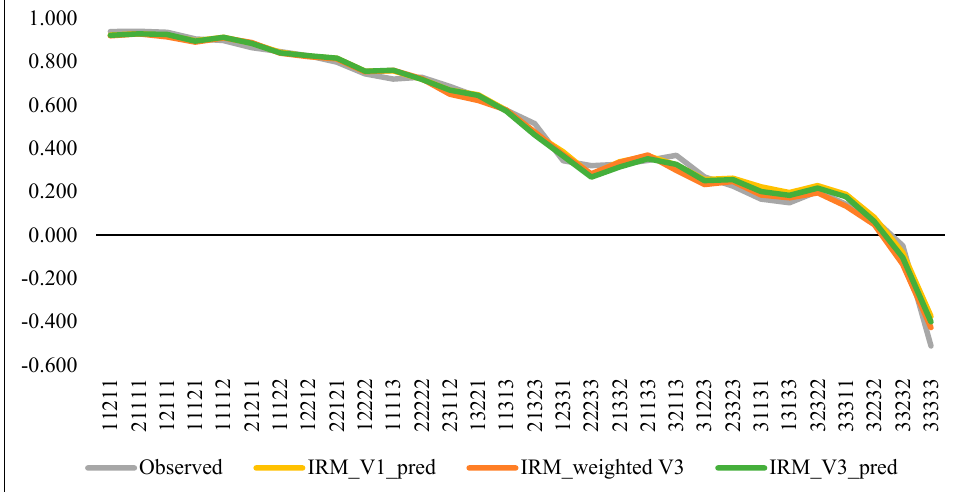
Figure 1. Observed and predicted values for evaluated health states. We compared the observed cTTO values from our study with the observed TTO values from the UK MVH study [43] for the 14 health states that were common to both studies. Table 6 shows the observed means (Observed) and standard deviations (SD) for both countries, the number of respondents (n) who evaluated the health states in each study, and the predicted values (Predicted). Additionally, we tested the statistical significance of the differences between the observed means for Romania and the observed means in the UK. We found significant results at the 0.05 level for all compared states, except 33333. Values for Romania were generally higher than those recorded in the UK for all states, except 33232, for which Romanian values were significantly smaller (Table 6). Differences between health states ranged from − 0.42 (for 21133) to − 0.06 (corresponding to 11121) (see Figure 2). Table 6. Comparison between common evaluated states in Romania and the UK. Health TTO UK TTO